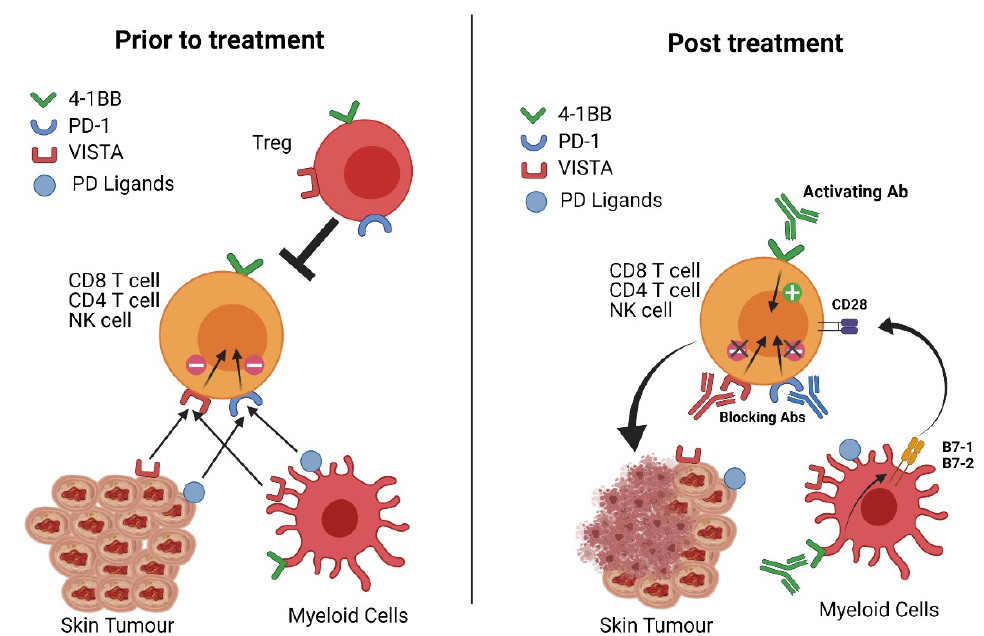
Figure 1. A model of the key interactions that are proposed to enhance the activity of T cells/NK cells within the tumor microenvironment after treatment with antibodies targeting PD-1, VISTA and 4-1BB. Prior to antibody treatment (left side), CD4/CD8 T cells and NK cells receive negative signals from interactions with ligands on the cancer and myeloid cells. In addition, there is a proposed lack of positive signals through 4-1BB and the presence of Treg cells that inhibit T cell/NK cell activity. Following antibody treatment (right side), T cells/NK cells are activated due to the antibody blocking of PD-1 and VISTA and the agonistic activity of 4-1BB. In addition, anti-4-1BB antibody is known to delete Treg cells (no longer shown in the diagram) and induce costimulation (such as B7 family members) on dendritic cells allowing activating signals through CD28. The end result is destruction of the tumor by T/NK cells. Note that not all T/NK cells will express all three receptors simultaneously leading to different levels of functional restoration within individual T/NK cells in the tumor microenvironment (image created with BioRender.com (accessd on 12 May 2021)).